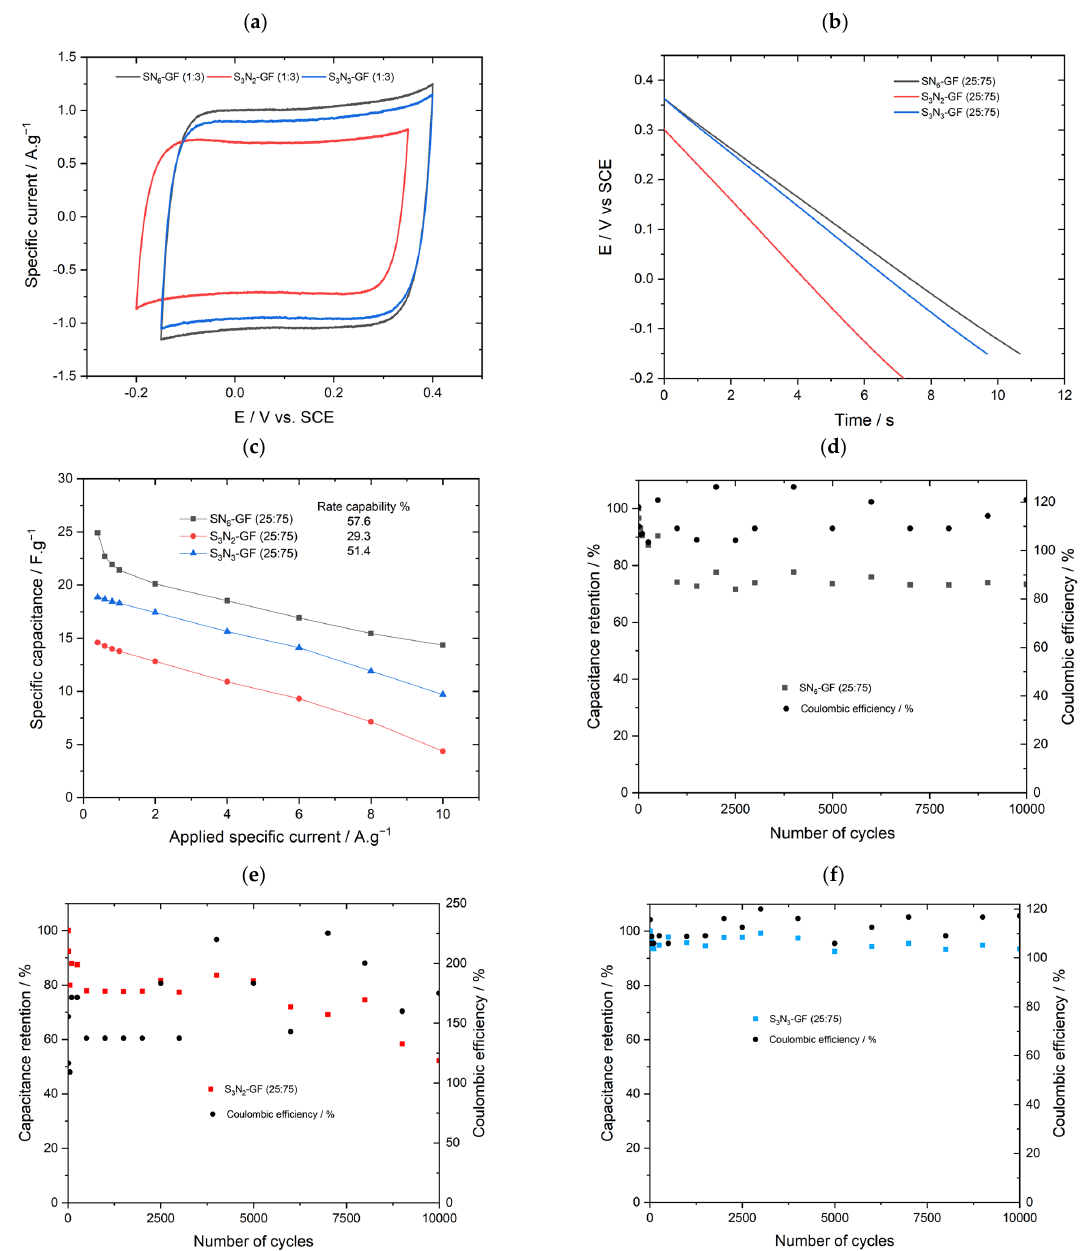
Figure 4. Electrochemical results for different dopants and different dopant ratios in 1 M Na 2 SO 4 electrolyte, for SN 6 − GF (25:75), S 3 N 2 − GF (25:75), and S 3 N 3 − GF (25:75): ( a ) cyclic voltammetry at 50 mV ∙ s − 1 ; ( b ) discharge curves at 1.0 A ∙ g − 1 ; ( c ) specific capacitance at specific current from 0.4 A ∙ g − 1 to 10.0 A ∙ g − 1 ; and capacitance retention after 10,000 cycles of continuous charge–discharge at 10.0 A ∙ g − 1 for ( d ) SN 6 − GF (25:75), ( e ) S 3 N 2 − GF (25:75) and ( f ) S 3 N 3 − GF (25:75).